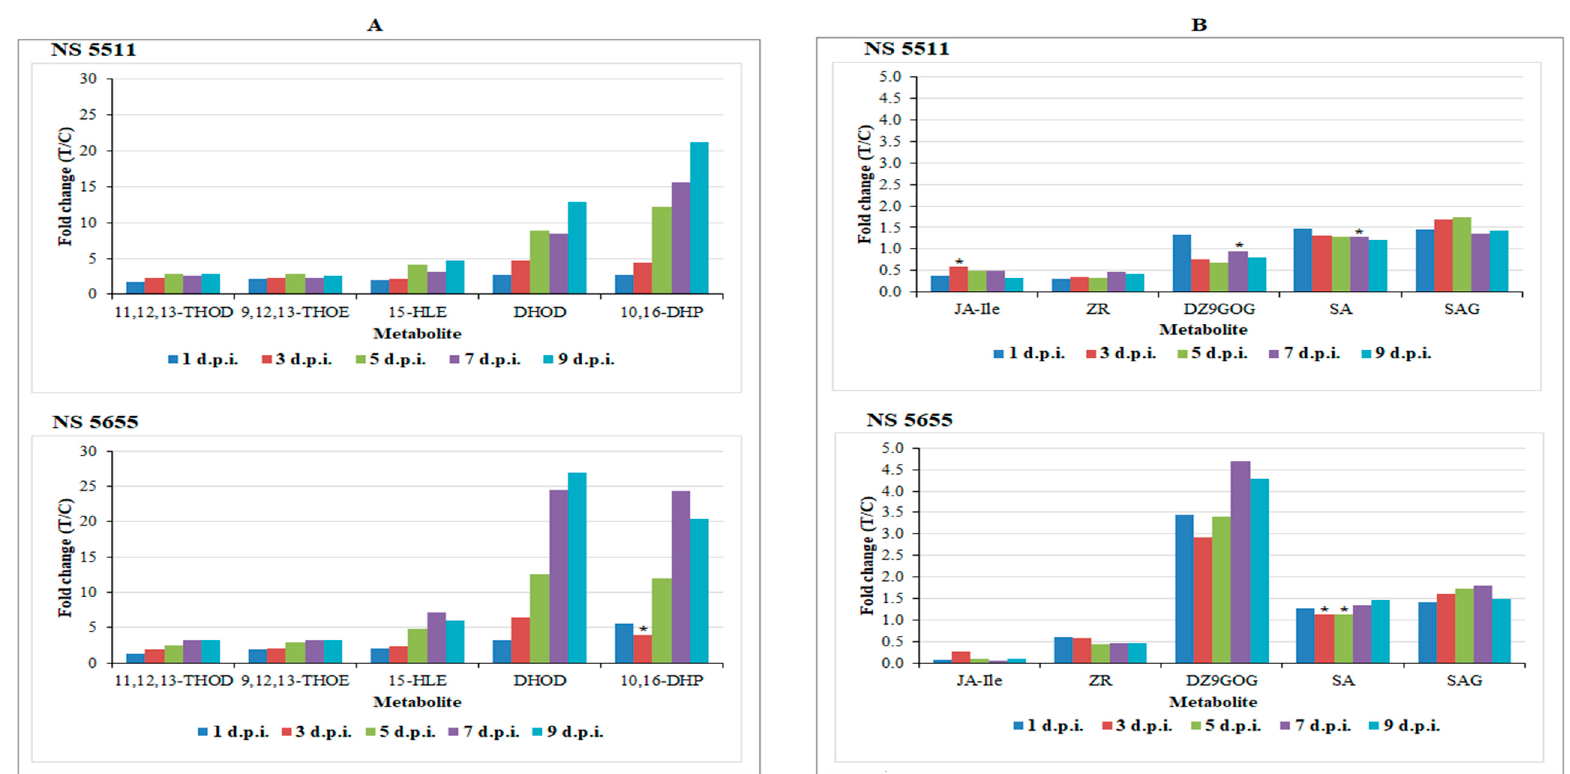
Figure 5. Relative quantification of fatty acids ( A ) and phytohormones ( B ) annotated in sorghum leaves responding to infection by B. andropogonis . The relative levels of each metabolite are expressed as fold changes, computed from treated against control (T/C) samples, where fold change > 1 represents significant accumulation in NS 5511 (BT) and NS 5655 (ST). Abbreviations: (A) 11,12,13-THOD = 11,12,13-trihydroxy-9,15-octadecadienoic acid; 9,12,13-THOE = 9,12,13-trihydroxy-10-octadecenoic acid; 15-HLE = 15-hydroxylinoleic acid; DHOD = dihydroxy-octadecadienoic acid; 10,16-DHP = 10,16-dihydroxypalmitate (B) JA-Ile = jasmonoyl- L -isoleucine; ZR = zeatin riboside; DZ9GOG = dihydrozeatin-9- N -glucoside- O -glucoside; SA = salicylic acid; SAG = salicylic acid 2- O -beta- D -glucoside. The fold changes on the various treatment days presented in the graphs have a p -value < 0.005, except for the ones indicated by * with p -value > 0.005, but < than 0.05.